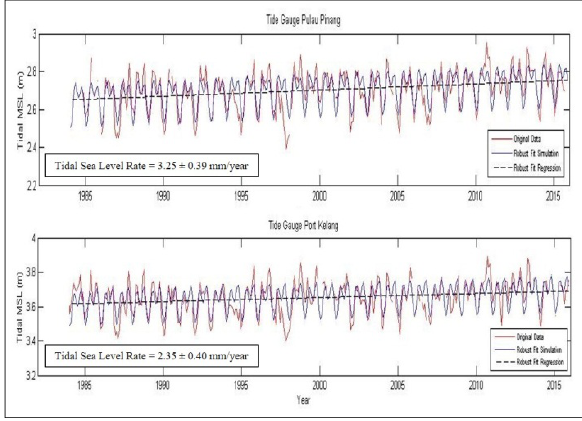
Figure 6. Tidal Sea Level Rate Between 1984 – 2015